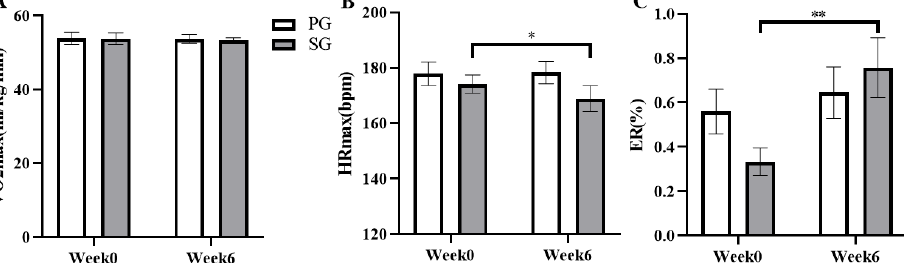
Figure 7. Comparison of the effects of the prebiotic and synbiotic on athletic performance during the maximal oxygen uptake and constant load test in elite football players. Results are presented as mean ± SEM. PG: prebiotic group (n = 15); SG: synbiotic group (n = 15). ( A ) VO2max. ( B ) HRmax. ( C ) ER. *: p < 0.05; **: p < 0.01.